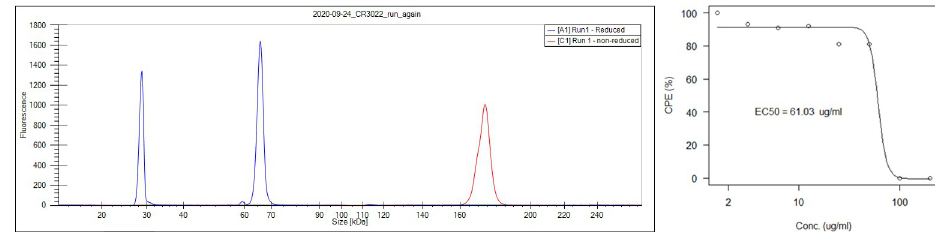
Fig 1. a. CE-PAGE profile of purified CR3022. The Conamax-produced antibody was purified to an apparent 100% purity by a single Protein A chromatography step. Red curve: non-reduced sample, blue curve: reduced, showing heavy and light chains. b. Antibody CR3022 produced by Conamax was able to inhibit induced cytopathy by SARS-CoV-2 in Vero 76 cells. The EC 50 was 61 μ g/ml in this assay. Data shown here are averages of three observations per concentration of